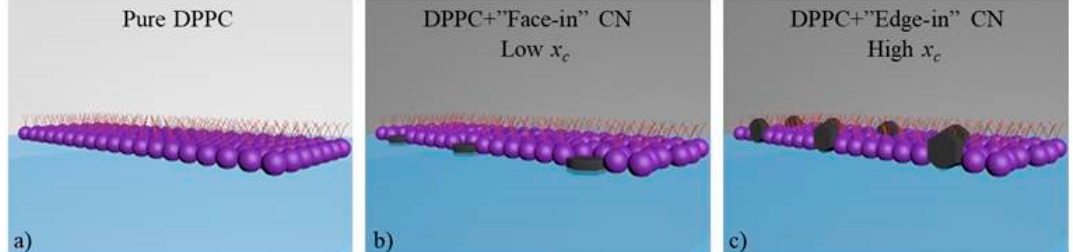
Figure 4. Scheme of the possible distribution of DPPC and CN at the water / vapor interface as x c increases: ( a ) Pure DPPC monolayer. ( b ) Monolayer of DPPC and CN in “face-in” orientation. ( c ) Monolayer of DPPC and CN in “edge-in” orientation. The di ff erent brightness of the upper region of panel a in relation to panels b and c pretends the existence of di ff erent environments (clean vs. polluted). Notice that the adsorption of DPPC molecules onto the CN surface is not shown explicitly in the scheme. It is expected that this adsorption can be more favored in the “face-in” (low values of x c ) orientation than in the “edge-in” (high values of x c ) one.